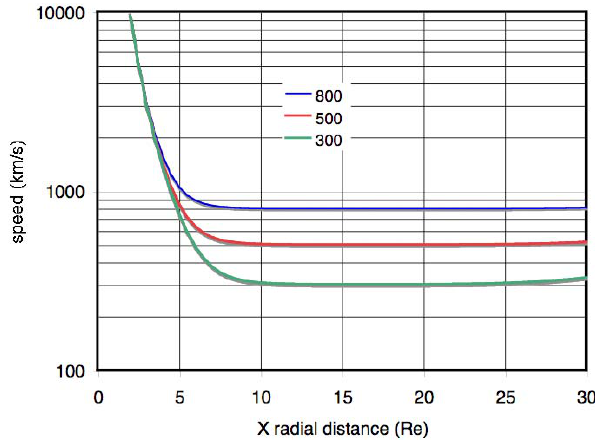
Fig. 4. The propagation speed as a function of the radial distance, Figure 4. The propagation speed as a function of the radial distance, X from the Earth along the neutral sheet using Tsyganenko 1989 and a plasma density of 0.3 cm -3 . At X from the Earth along the neutral sheet using Tsyganenko 1989 distances >10 Re the iono-acoustic speed becomes dominant and we assumed three and a plasma density of 0.3cm − 3 . At distances > 10 R E the iono- constant values 300, 500 or 800 km/s. acoustic speed becomes dominant and we assumed three constant values 300, 500 or 800km/s. .